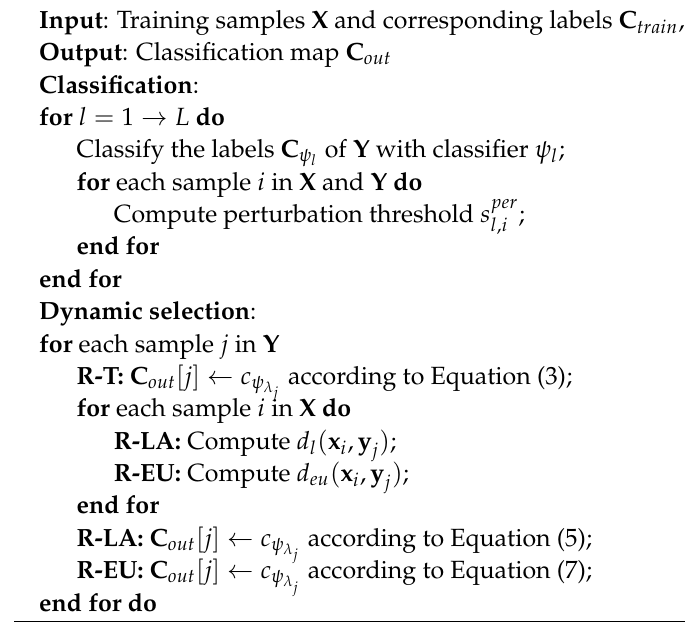
Algorithm 1 Robust dynamic classifier selection (R-DCS)